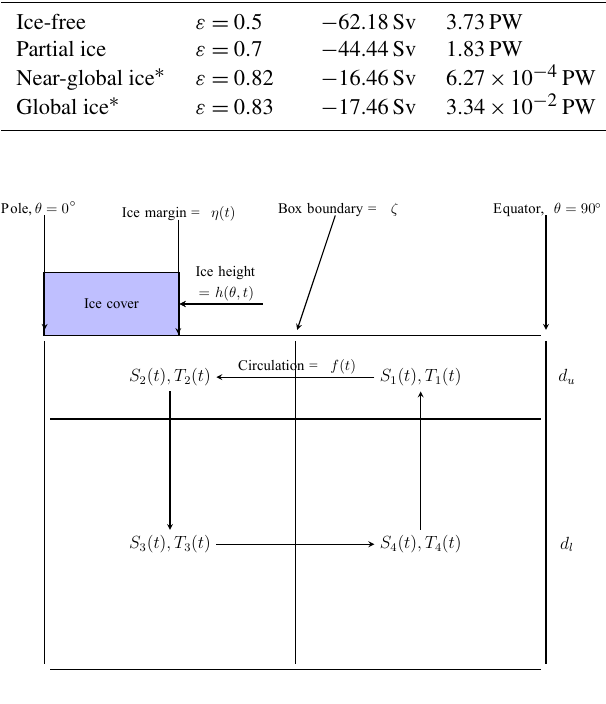
Figure 1. Hemispheric four-box arrangement. Boxes 1 and 2 are the surface ocean boxes of depth d u , and Boxes 3 and 4 are the deep ocean boxes of depth d l . The water in Box i has (well-mixed) salin- ity S i and temperature T i . The boundary between polar and equato- rial boxes is at latitude ζ . Ice cover sits atop the surface boxes with height h and the ice margin at η . The arrows between the boxes represent density-driven circulation f